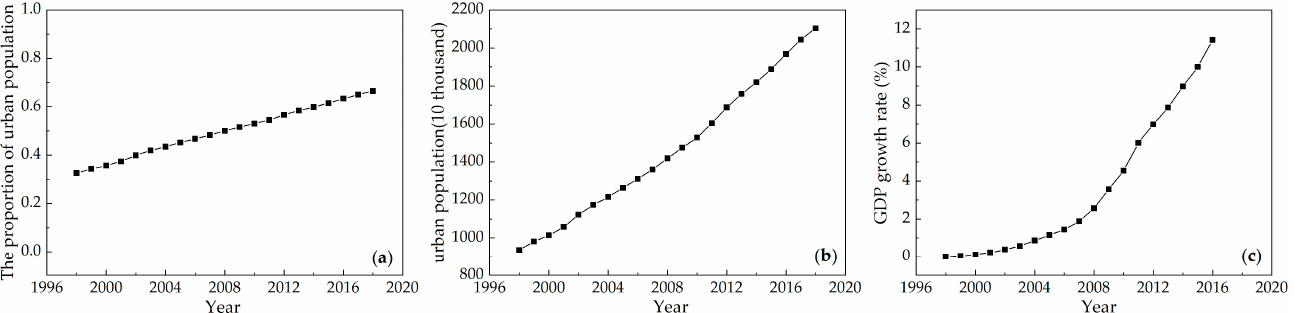
Figure 2. ( a ) The proportion of urban population in Chongqing; ( b ) urban population in Chongqing; ( c ) GDP growth rate from 1998 to 2016 (source: Chongqing Statistical Yearbook). Data for each year are indicated with black dots.